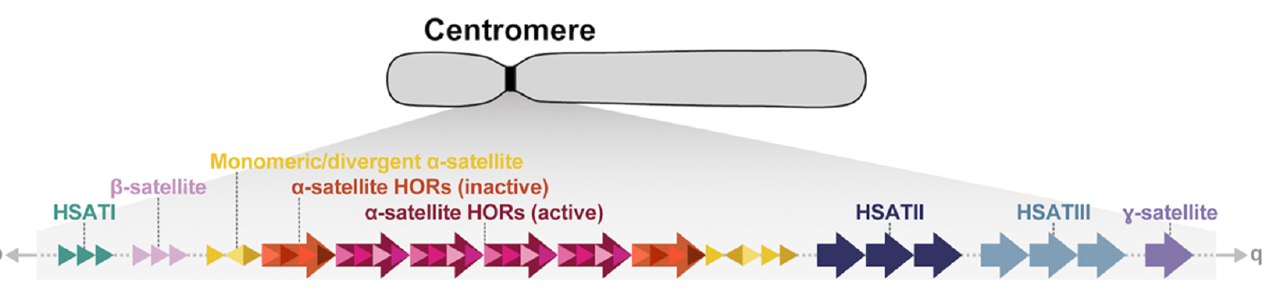
Figure 1. Model of human centromeric and pericentromeric regions. Schematic of the generalized organization of human centromeres and their flanking sequence. Major components and their structures are shown. HORs, higher-order repeats; HSAT, human satellite. Not drawn to scale. Table 1. Composition and abundance of repeats within human centromeric and pericentromeric regions.